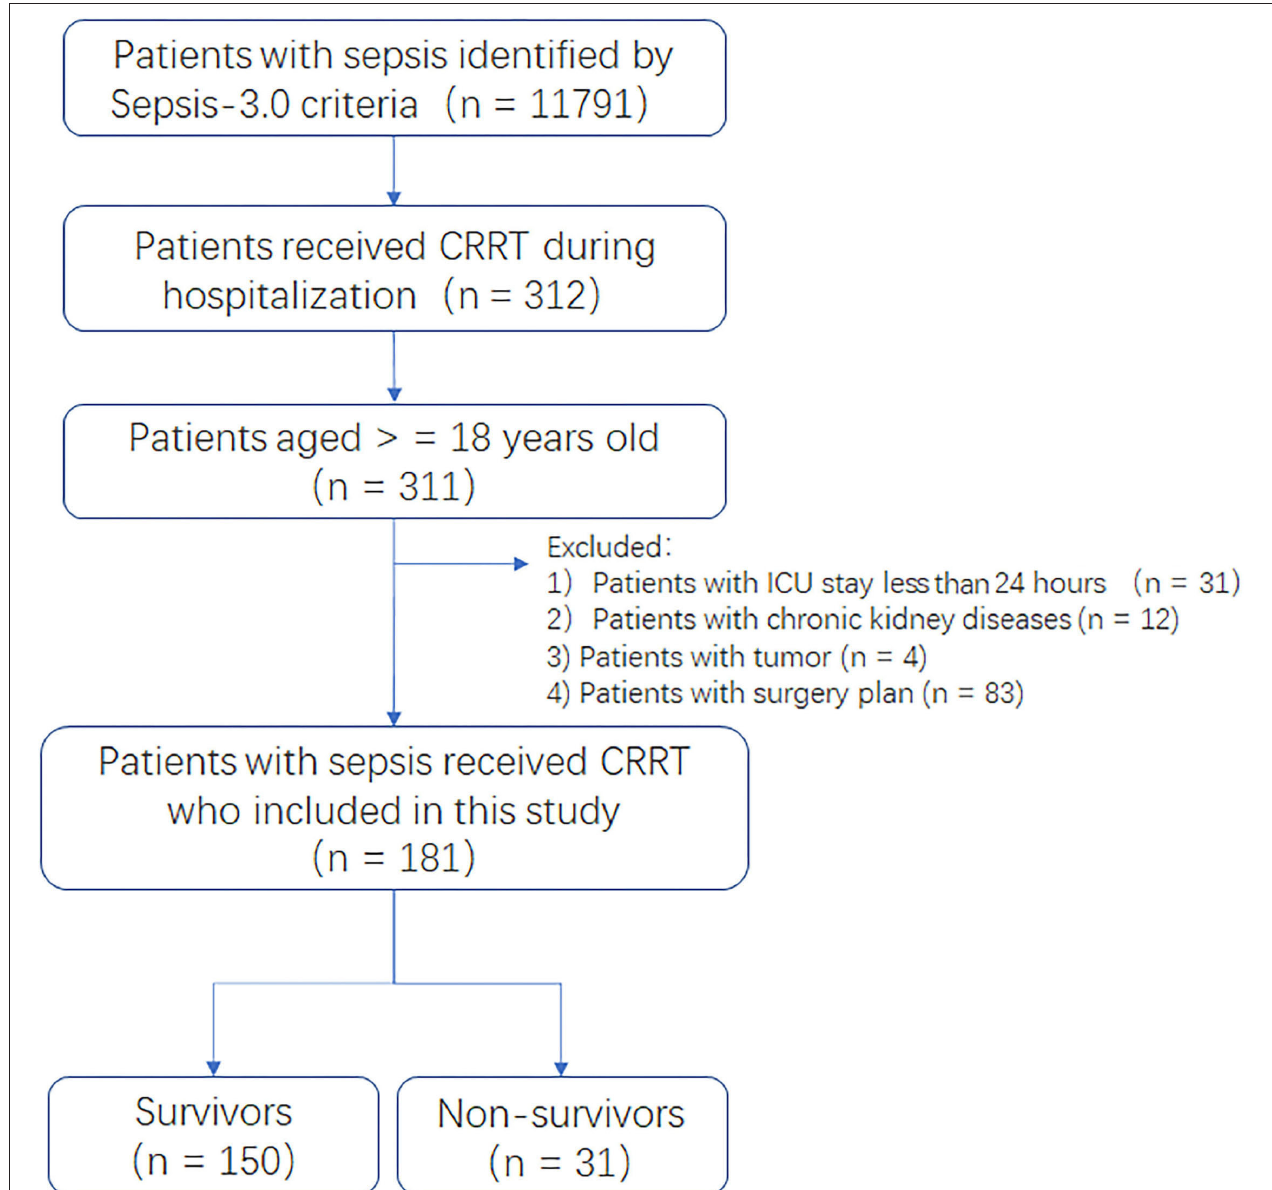
FIGURE 1 | Flow chart of patient selection and data